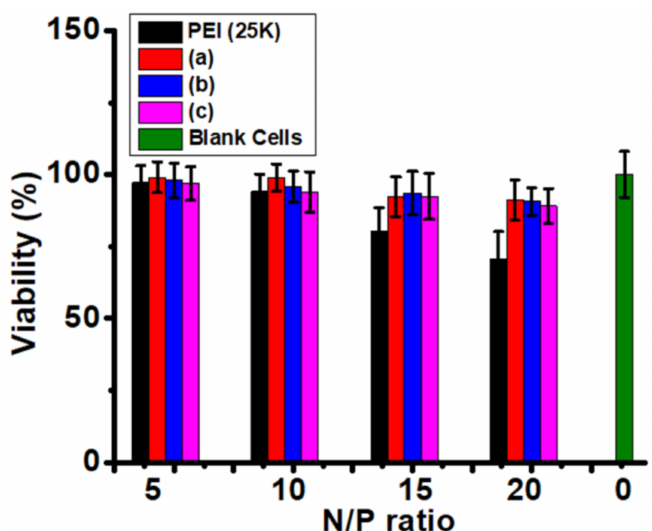
Figure 7. Toxicity assessment of nanocomposites of plasmid DNA and (a) poly( L -lysine) 50 - block - poly( L -leucine) 10 , (b) poly( L -lysine) 50 - block -poly( L -leucine) 15 , (c) poly( L -lysine) 50 - block -poly( L -leucine) 25 , and control (PEI, 25 K) by using COS-7 cells at various N/P (mean ± SD, n = 3).